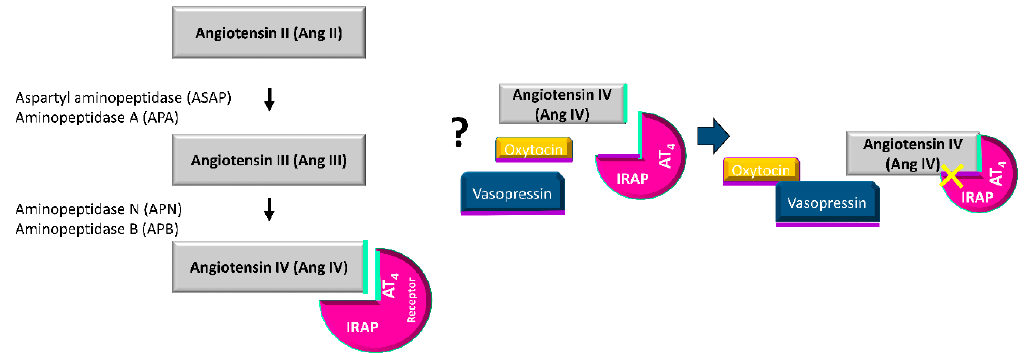
Figure 4. Potential regulation of the catalytic activity of IRAP by the binding of angiotensin IV